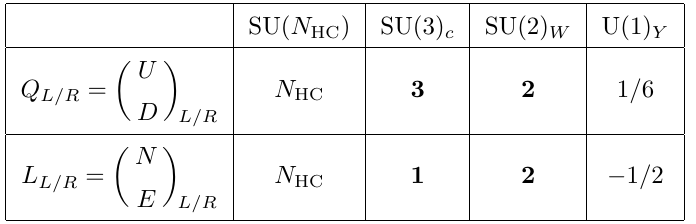
Table 1 . The SM charge assignment for eight HC fermions F L=R = ( Q; L ) T